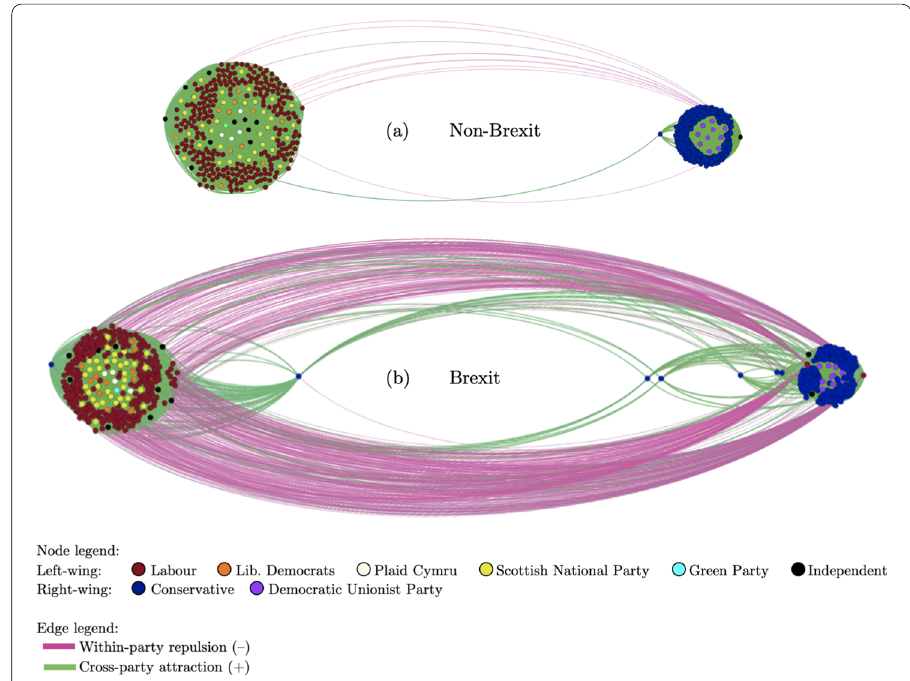
Fig. 2 Network projection of dissent and rebellion for non-Brexit ( a ) and Brexit ( b ) divisions, for the 8 political party case. Each node denotes an MP, connected by an edge to another MP. The colour of the edge represents whether the connection is a repulsive (push) or attractive (pull) force. Node colours denote party